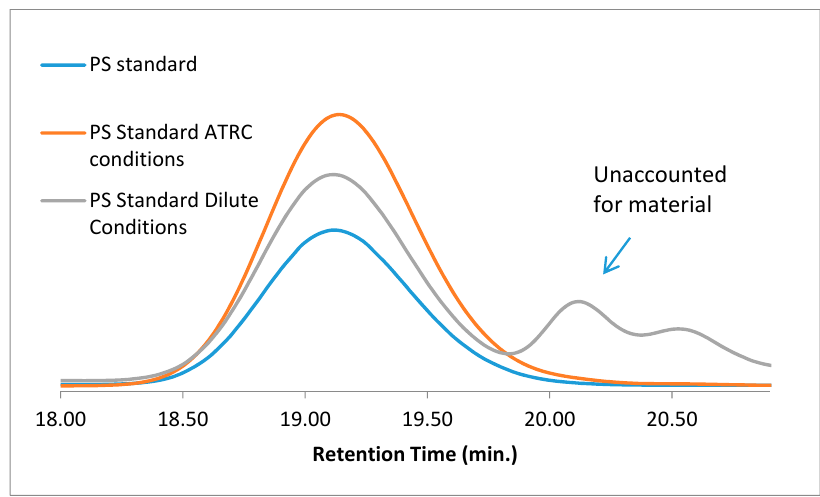
Figure 4. GPC traces of unfunctionalized PS (Blue; purchased from Aldrich, Saint Louis, MO, USA) and unpurified product of mock “dimerization reaction” (orange) and mock, high ‐ dilution “cyclization reaction”. Note that these simply mimic cyclization or ATRC reactions, using a nonreactive polymer incapable of chain ‐ end ‐ joining reactions. ATRC reaction conditions: 60 °C and [PS standard] = 15 mM. Dilute reaction conditions of 60 °C and [PS standard] = 0.1 mM. Polystyrene standard characteristics: M n : 3100 Da; M p : 3300 Da.